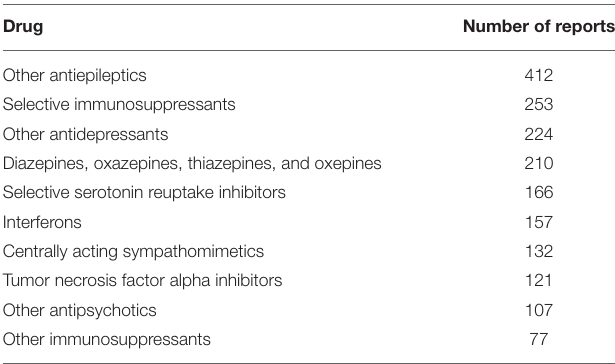
TABLE 3 | Top 10 drug groups at the fourth ATC level ranked according to the highest number of reports in VigiBase. Drug Number of